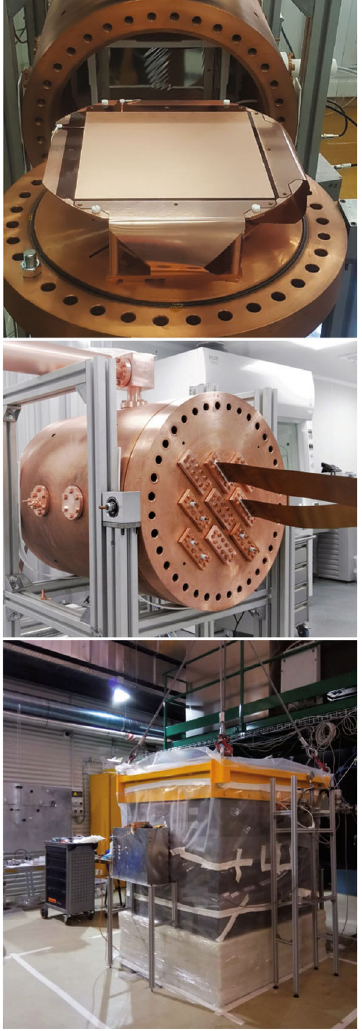
Fig. 1 Pictures of the Microbulk Micromegas of TREX-DM, the largest ever fabricated, being tested (top), the copper vessel at the clean room of LSC during mounting (middle) and the set-up with the lead shielding at hall A of LSC (bottom)